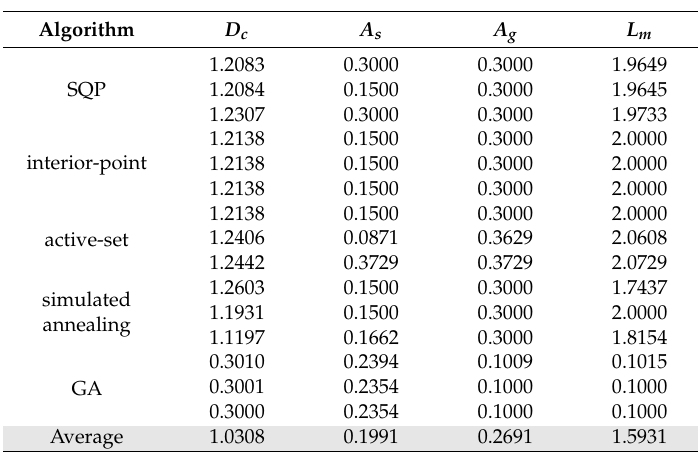
Table 6. Optimum